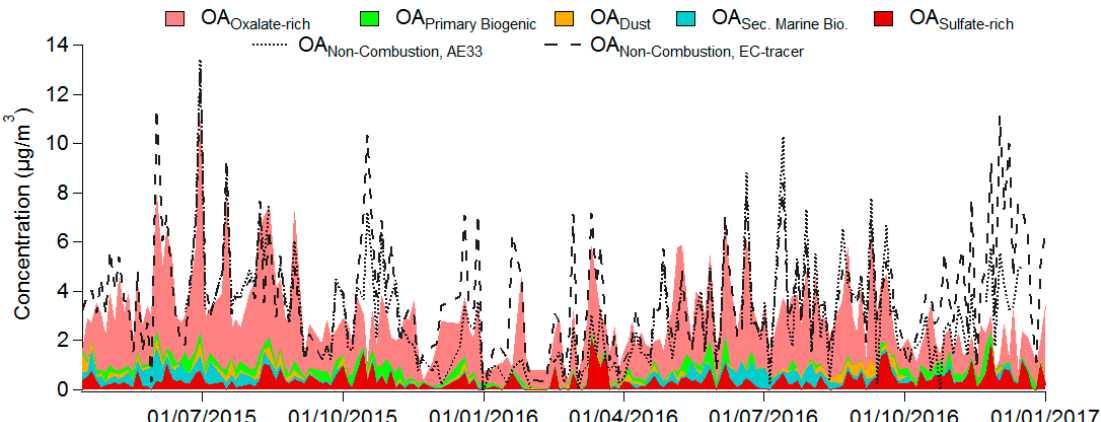
Figure 6. Timeseries of the non-combustion sources to OA from the PMF factors (stacked filled colors), and the two independent approaches (AE33-based and EC-tracer) described in Section 2.2.